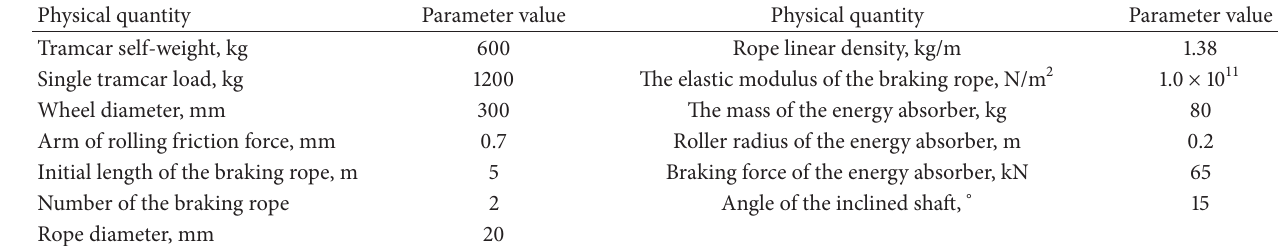
Table 7: Parameters of tramcar and energy absorber.